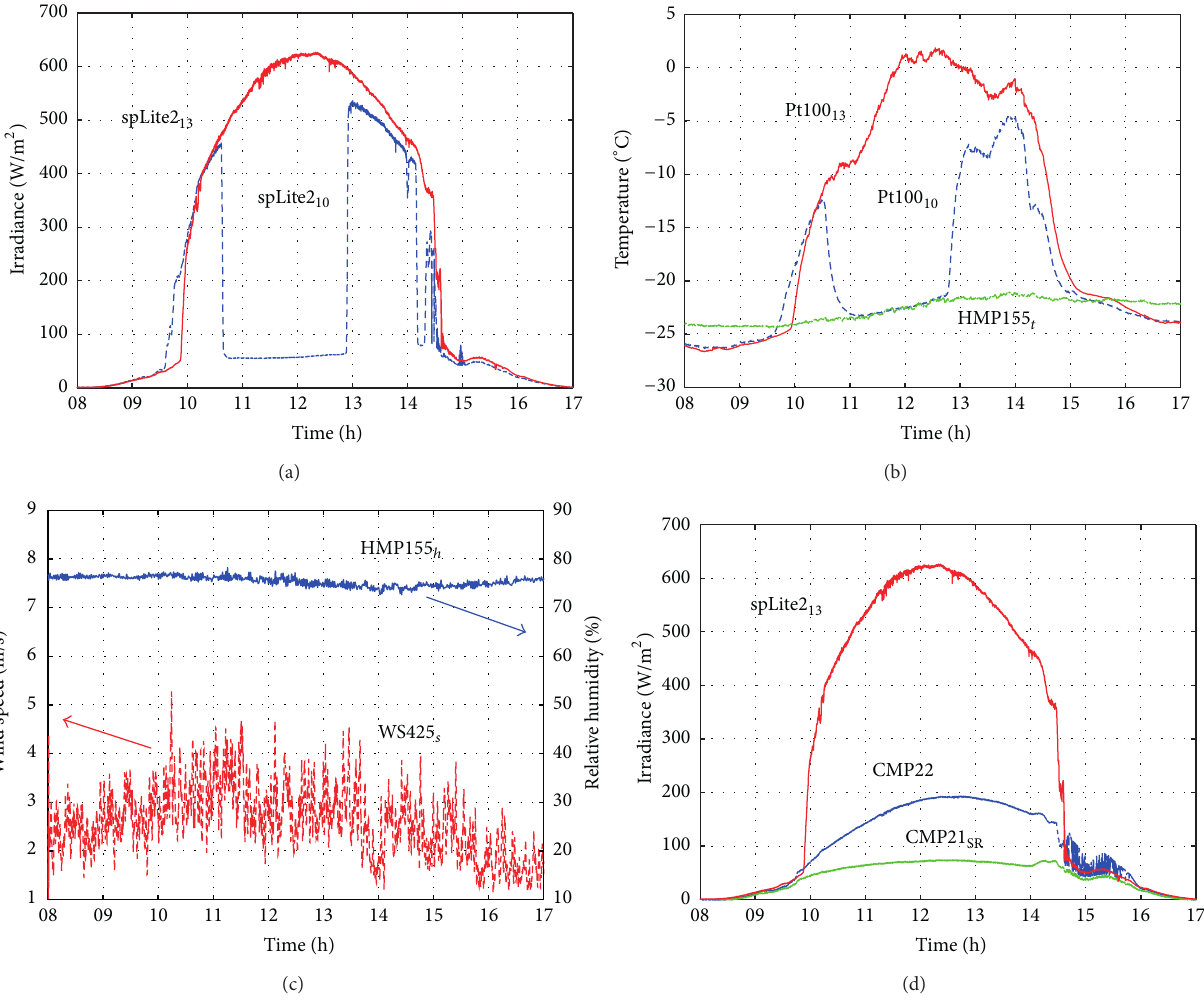
Figure 7: Irradiance and climatic data measured on a sunny day of February 2nd, 2012: (a) irradiances received by two PV modules equipped with irradiance and temperature sensors S10 and S13 (see Figure 2), (b) corresponding module temperatures together with the ambient ,(c)windspeedandrelativehumiditymeasuredbysensorsWS 425 temperaturemeasuredwithsensorHMP 155 T (d) irradiance received by the PV module equipped with sensor S13 together with the global and diffuse irradiances at the research plant measured by pyranometers CMP22 and CMP21,